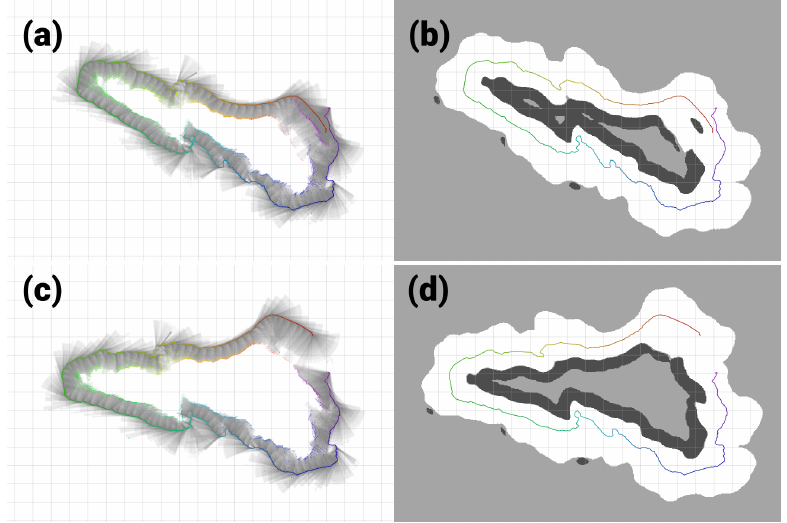
Figure 19. Rocks dataset results. ( a , b ) Original dataset. ( c , d ) Corrected dataset. ( a , c ) Raw rays and endpoints with the vehicle trajectory colored by time. ( b , d ) Learned HM segmented to show free/unknown/occupied values with the vehicle